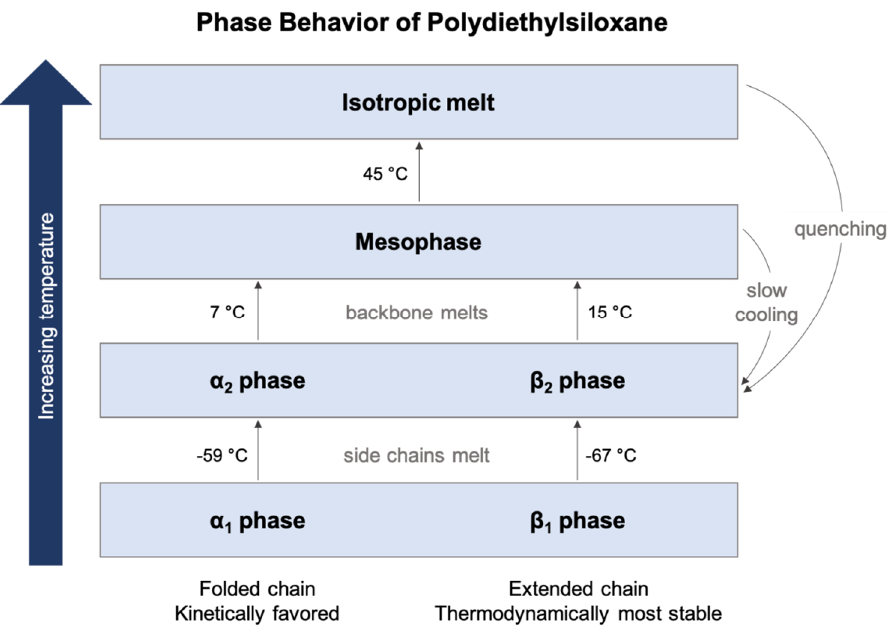
Figure 16. Liquid Crystal-Phase Behavior of Polydiethylsiloxane.